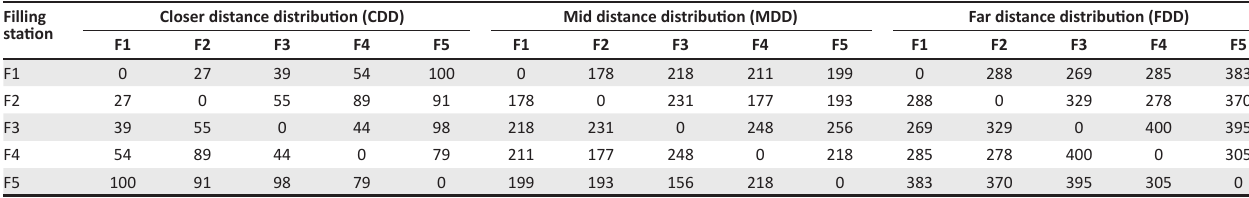
TABLE 6: Distance between filling stations (i.e. the distance between filling station 1 and 2 per km). Filling